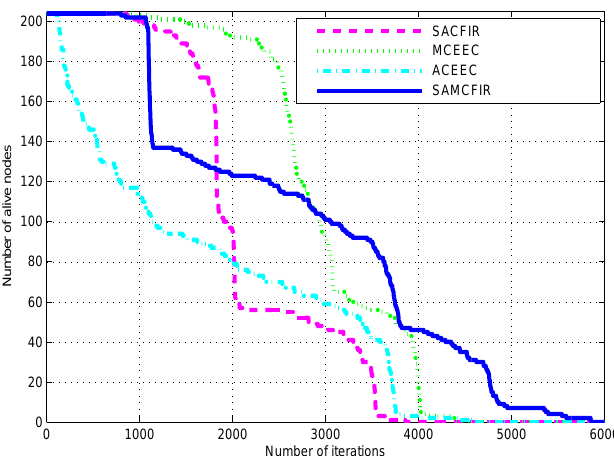
Figure 10. Energy Efficiency in terms of network lifetime in network of 300 m × 300 m with 200 nodes.